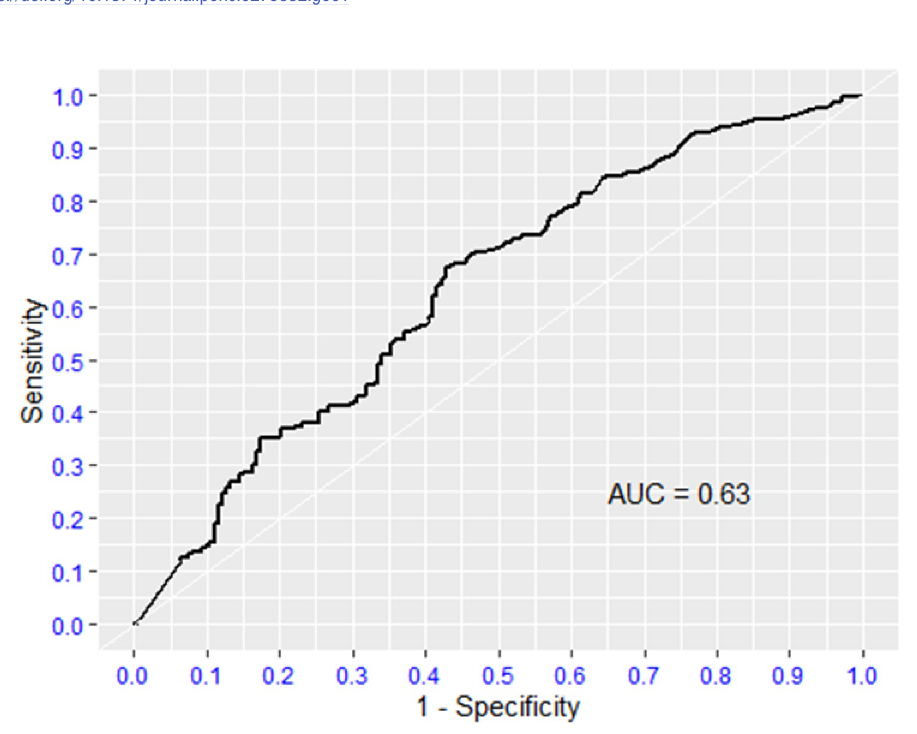
Fig 2. ROC curve D-dimer.